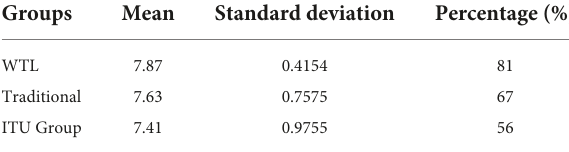
TABLE 3 Arithmetic test score.